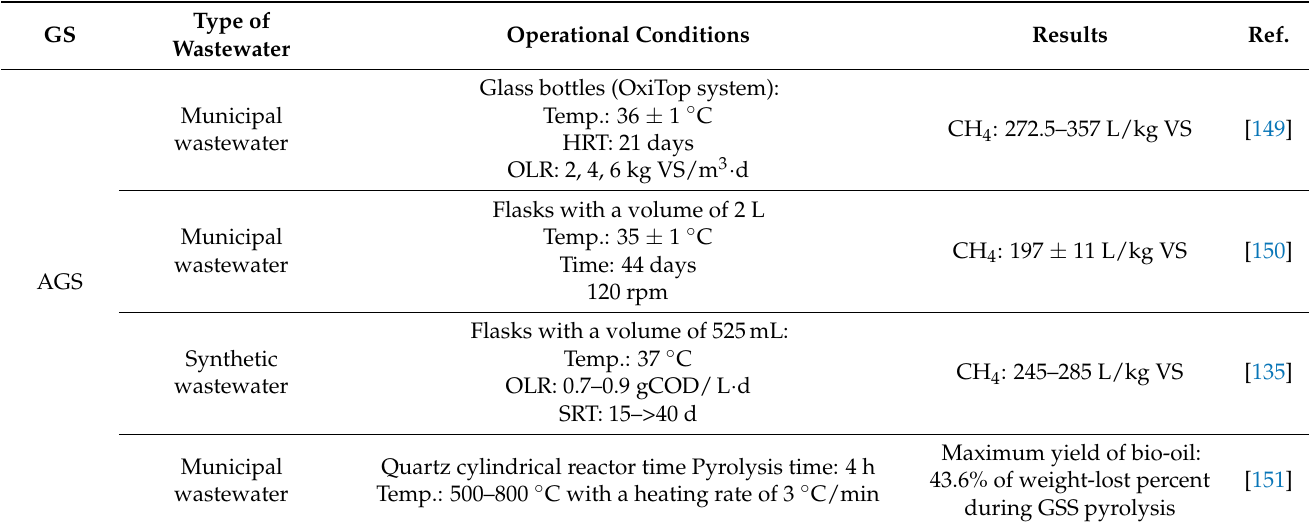
Table 7. Example applications of granular sludge in energy generation and their efficiencies.